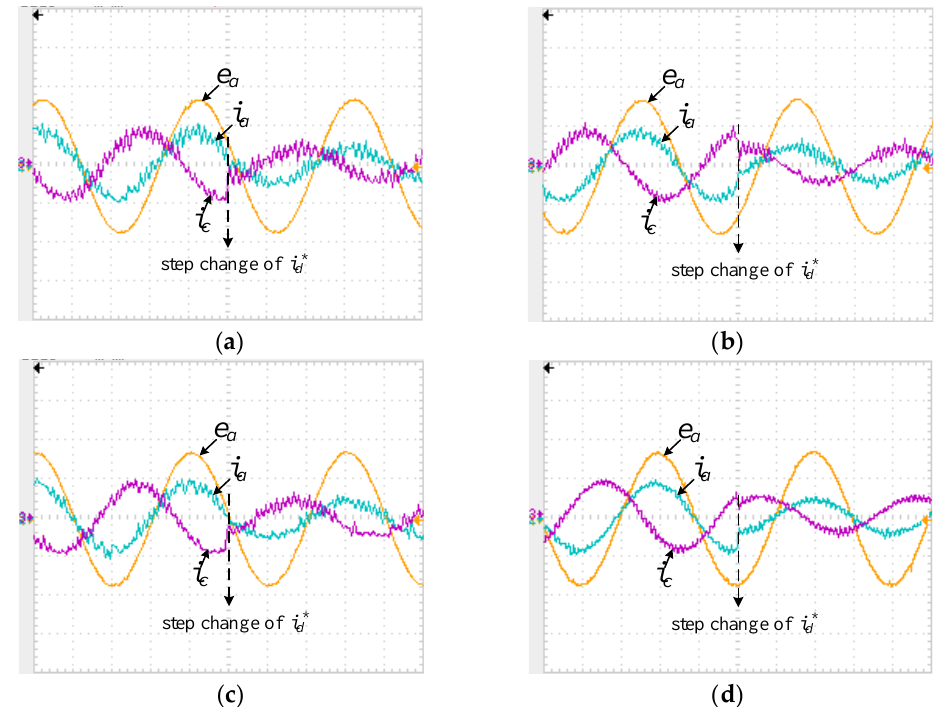
Figure 8. Dynamic performance of four MPC methods (20 V/div, 10 A/div, 5 ms/div): ( a ) MPC1; ( b ) MPC2; ( c ) MPC3; ( d ) Proposed MPC.